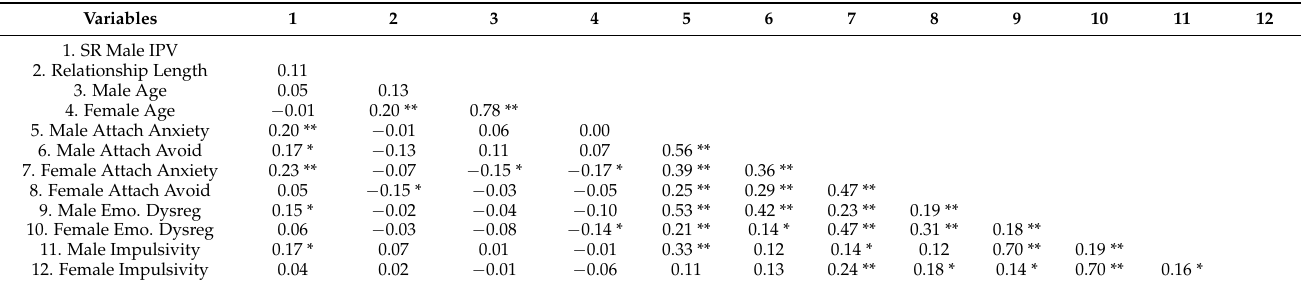
Table 2. Bivariate correlations among self-reported male intimate partner violence (IPV), relationship length, age, attachment, emotion dysregulation, and impulsivity.